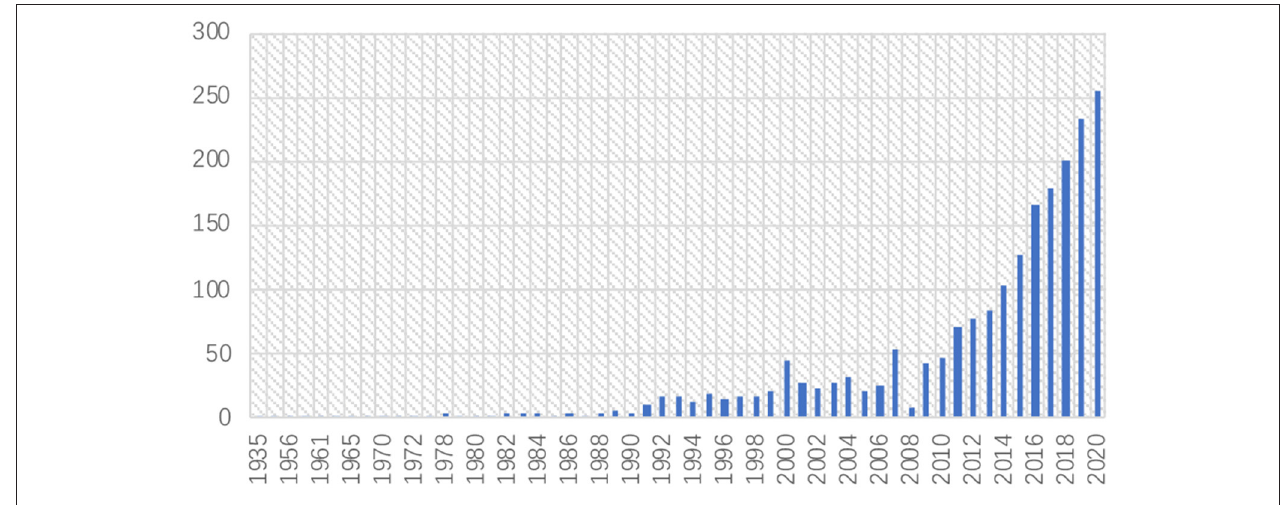
FIGURE 1 | Distribution of publications on the topic of procrastination,